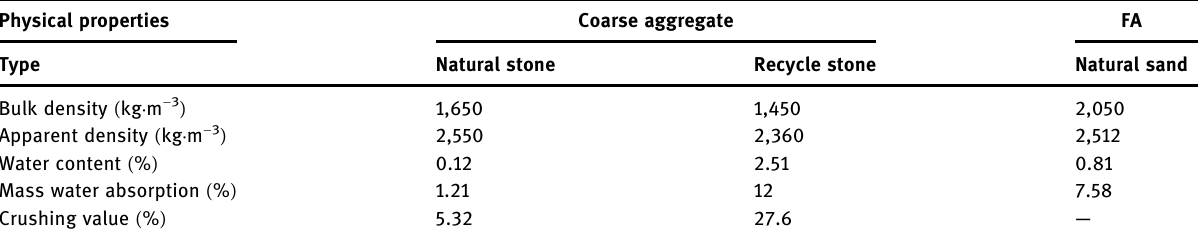
Physical properties